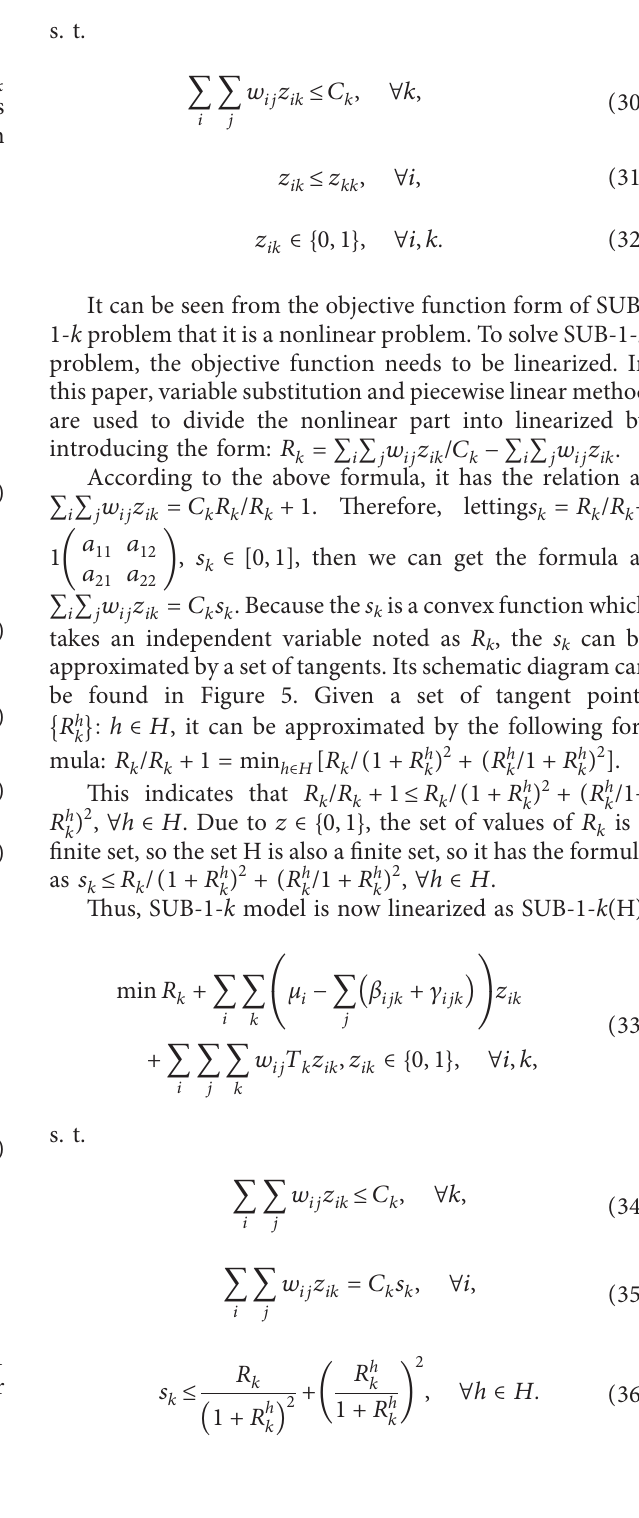
Table 7: The variables involved in the Lagrangian relaxation heuristic algorithm. Parameter Descriptions χ Weight coefficient in the objective function μ i Lagrange